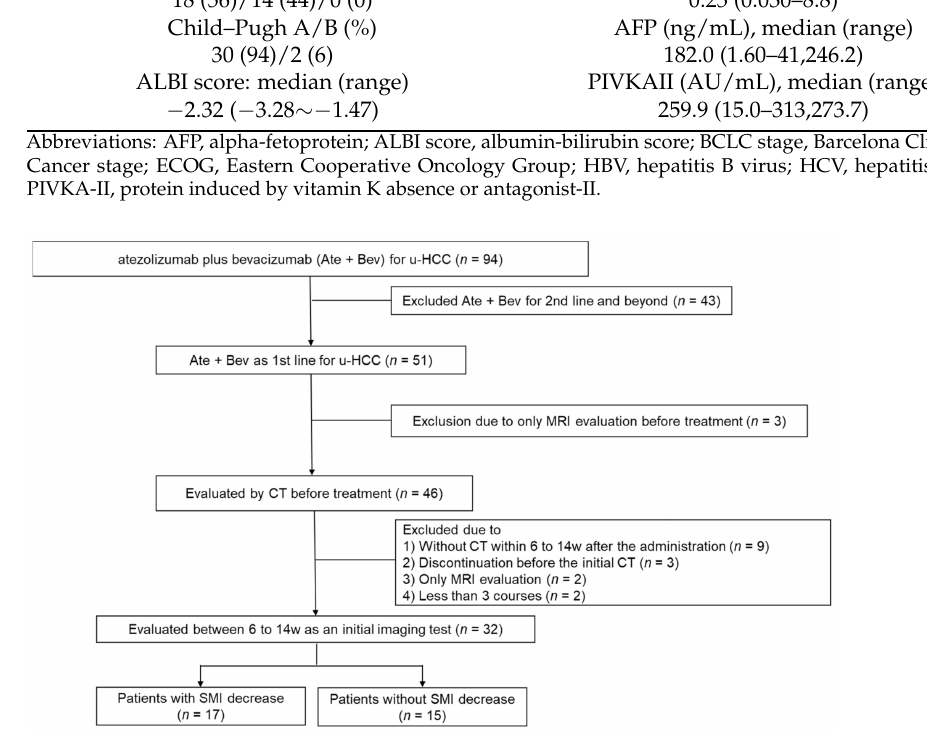
Figure 1. Flow diagram of the study